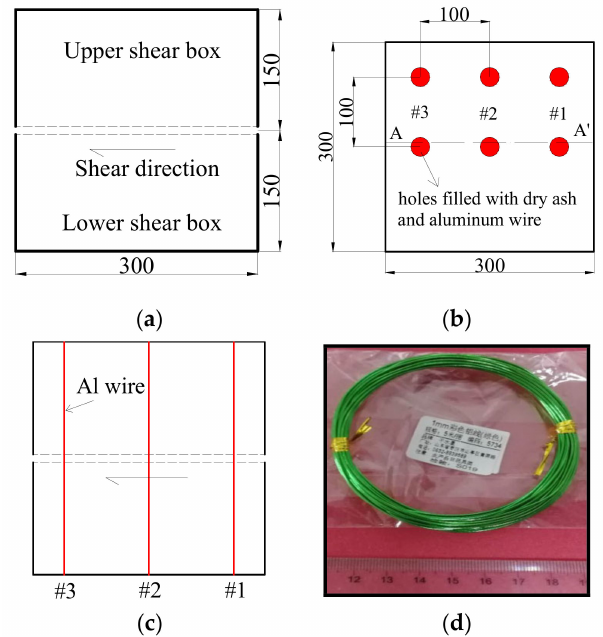
Figure 5. Schematic of the installation of Al wires. ( a ) Front view of the shear box (mm); ( b ) the top surface of the shear box (mm); ( c ) profile map of AA’ in ( b ); ( d ) aluminum (Al) wires with a diameter of 1.0